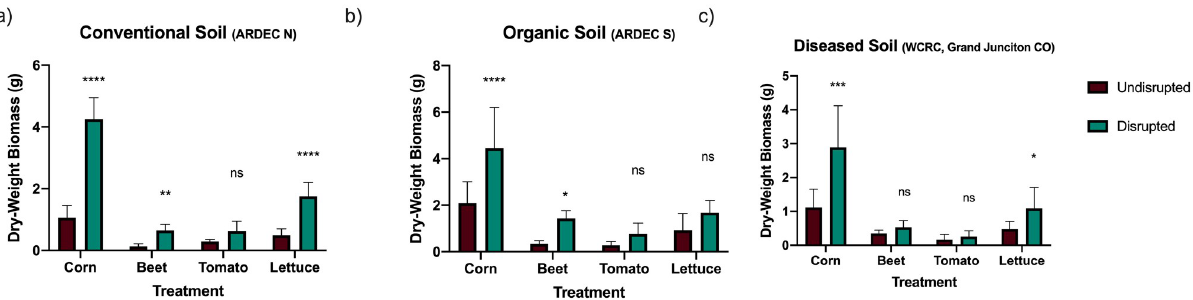
Fig 1. Mean dry-weight (DW) biomass measurements for each crop in each soil treatment (n = 10 per crop per soil treatment, ± standard deviation). (a) DW biomass results from crops grown in organic soil (b) DW biomass of crops grown in conventional soil (c) DW biomass of all crops grown in diseased soil. Red or blue bars represent the mean DW biomass for each crop in undisrupted or disrupted soil respectively. Significant differences between mean. DW biomass of crops grown in disrupted or undisrupted soils are denoted by “ � ”, “ �� ”, “ ��� ” or “ ���� ”. Figure created using GraphPad’s Prism (Vers. 8.2.1).